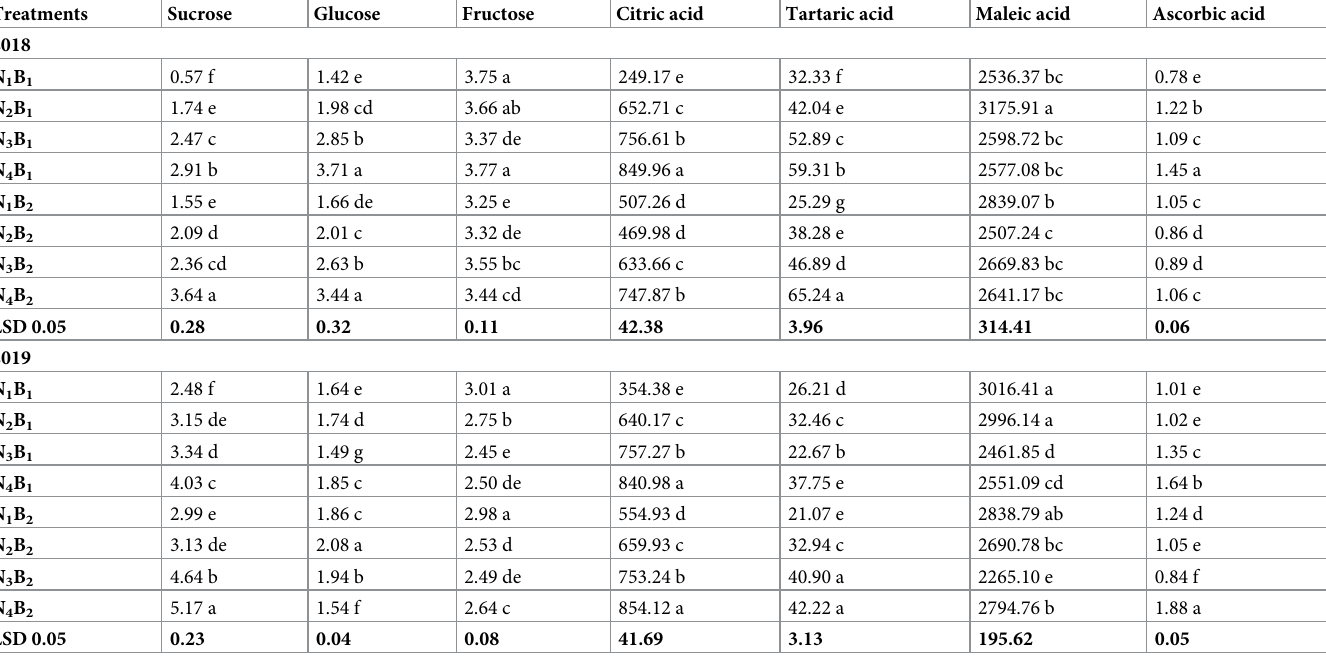
Table 7. The impact of nitrogen by boron doses interaction on the fruit quality attributes of grafted watermelon grown under climatic conditions of C¸ukurova region. Treatments Sucrose Glucose Fructose Citric acid Tartaric acid Maleic acid Ascorbic acid